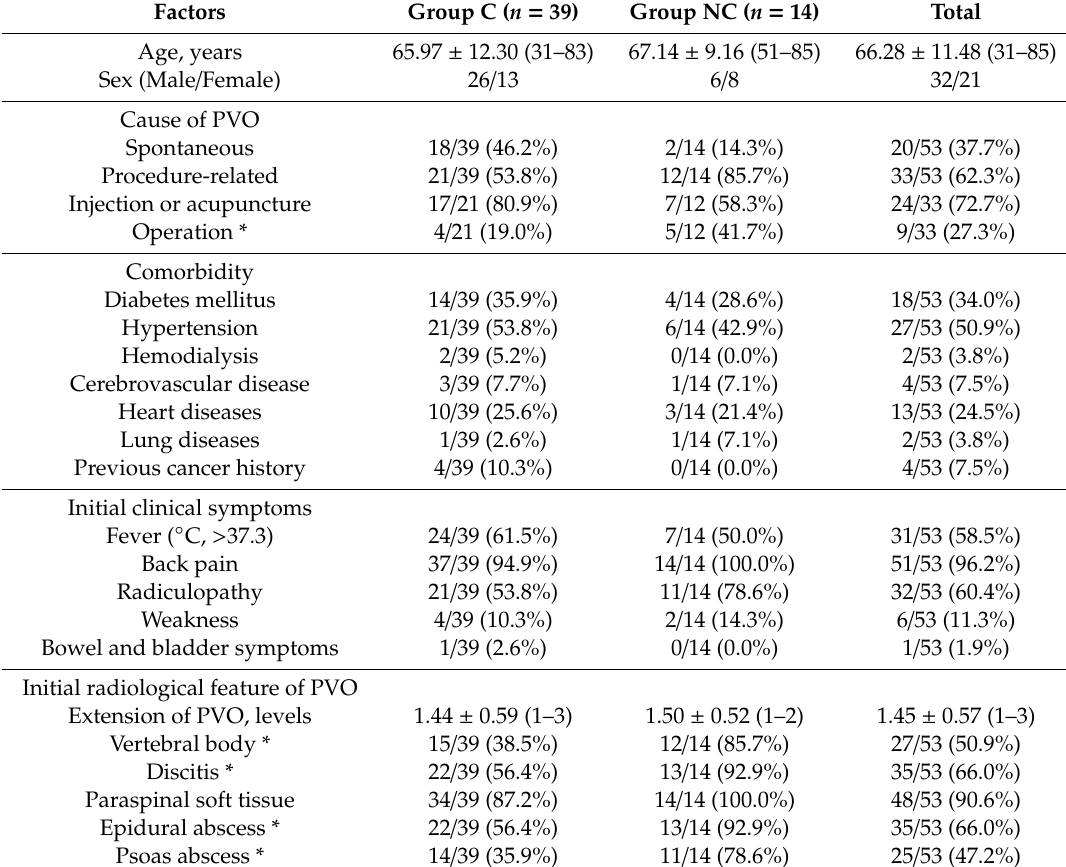
Table 2. Demographic and clinical